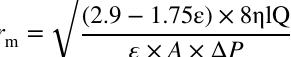
Fig. 3 Zeta potential of the M1, M3 and M5 at different